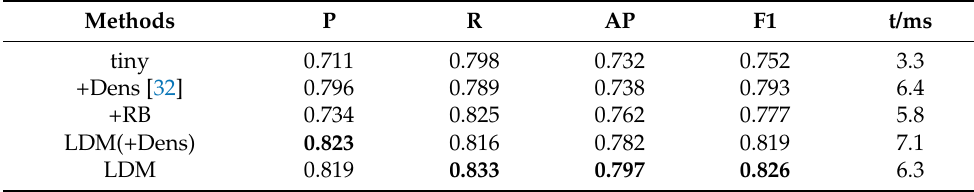
Table 4. The RB module vs. dense